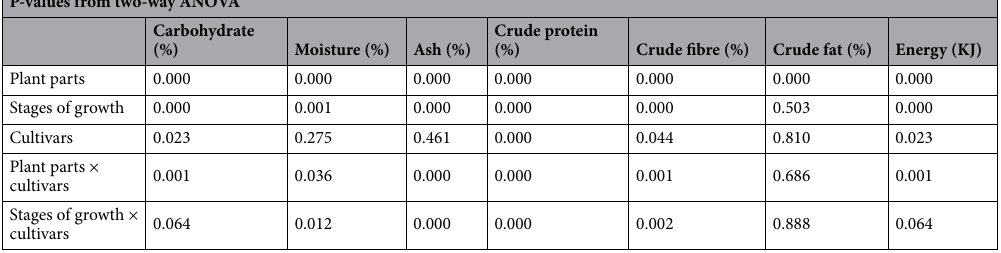
roselle, however, significant differences in their interaction occurred on carbohydrates, crude fat and energy contents. Effects of the treatments on mineral contents. The magnesium content in the samples ranged from 365 ± 7.07 to 555 ± 21.2 mg. The value of magnesium in red roselle at the pre-flowering stage was the highest, followed by that of green calyces then red calyces. Post-flowering red had the least value. Calcium content in the samples varied from 245 ± 7.07 to 2375 ± 35.36 mg. Ca content in red post-flowering was higher than other treatments, followed by pre-flowering red (1820 ± 14.14 mg). Seeds of red roselle had the least value of Ca though not significantly lower than green seeds (270 ± 0 mg). Red calyces Ca content was higher than the value in green calyces. Sodium (Na) content in the samples ranged from 10.0 ± 0 to 40 ± 28.28 mg. Red roselle seeds had the lowest Na content while red calyces had the highest value. Na content in the leaves and calyces were higher than those in the seeds, although the value in green was higher than red. Manganese (Mn) content in all the treatments ranged from 4.05 ± 0.07 to 29.4 ± 0.42 mg. Red calyces Mn content was the highest while the lowest value was recorded for flowering green. Mn values for both cultivars at the pre-flowering stage and red at the flowering stage, as well as green calyces, were not significantly different. Also, the Mn value at flowering and post-flowering stages of green roselle, as well as seed of red cultivar, were not different. Zinc (Zn) content in the samples ranged from 2.3 ± 0 to 5.55 ± 0.07 mg. The highest value was recorded for red seeds followed by green seeds (5.0 ± 0.14 mg); post-flowering red had the least value. There was no much variation in the content of Zn in roselle. Phosphorus content ranged from 125 ± 7.07 to 645 ± 7.07 mg. The phos- phorus content in the seeds of green roselle was higher than other treatments while red seeds and red calyces had the same but least value. The P content at pre-flowering and flowering stages were not significantly different. Copper (Cu) content in all the treatments varied from 0.5 ± 0 to 1.1 ± 0 mg. The Cu content in the seeds of red roselle was the highest and varied significantly from others including green seeds. The values of Cu in the two cultivars varied significantly in leaves (at each growth stage), calyces and seeds. Iron (Fe) was in the range of 15.31 ± 1.41–111.85 ± 12.8 mg, flowering red had the highest Fe content while flowering green had the least. There was no significant difference between the values at the pre-flowering stage of red and green roselle 26.25 ± 3.0 mg and 27.62 ± 1.13 mg as well as the Fe value at the post-flowering stage of red roselle. While the value at the post- flowering stage of green roselle did not vary significantly (P < 0.05) with the values in the calyces of both roselle. Potassium (K) was high in all the samples having a range of 1415 ± 7.07–2630 ± 127.28 mg. Pre -flowering red had the highest content of K followed by post-flowering green 2405 ± 77.80 mg while red seeds had the least content. Green calyces and pre-flowering green leaves were not significantly different while K content in red calyces was not significantly different from the values at the flowering stage of both cultivars. Also, K value at the post-flowering stage of red did not vary significantly from the values in the seeds of both cultivars. Sodium Potassium ratio (Na + /P +) for all the samples was far less than one, the highest value being 0.018 while the lowest was 0.01 (Table 3). Table 4 showed that plant parts and stages of harvest had no significant effects on the mineral composition of roselle except Na which showed a significant variation (P < 0.05). Also, the effects of cultivars on Na and copper were significant although no significant variation occurred in all other nutrient elements. Interaction of plant parts and cultivars had no significant effects on the elemental composition of roselle except Mg and Na which varied significantly. Also, the interaction of the stage of harvest with cultivars had no effects on the composition of nutrient elements except Na. Effects of the treatments on the vitamin content.